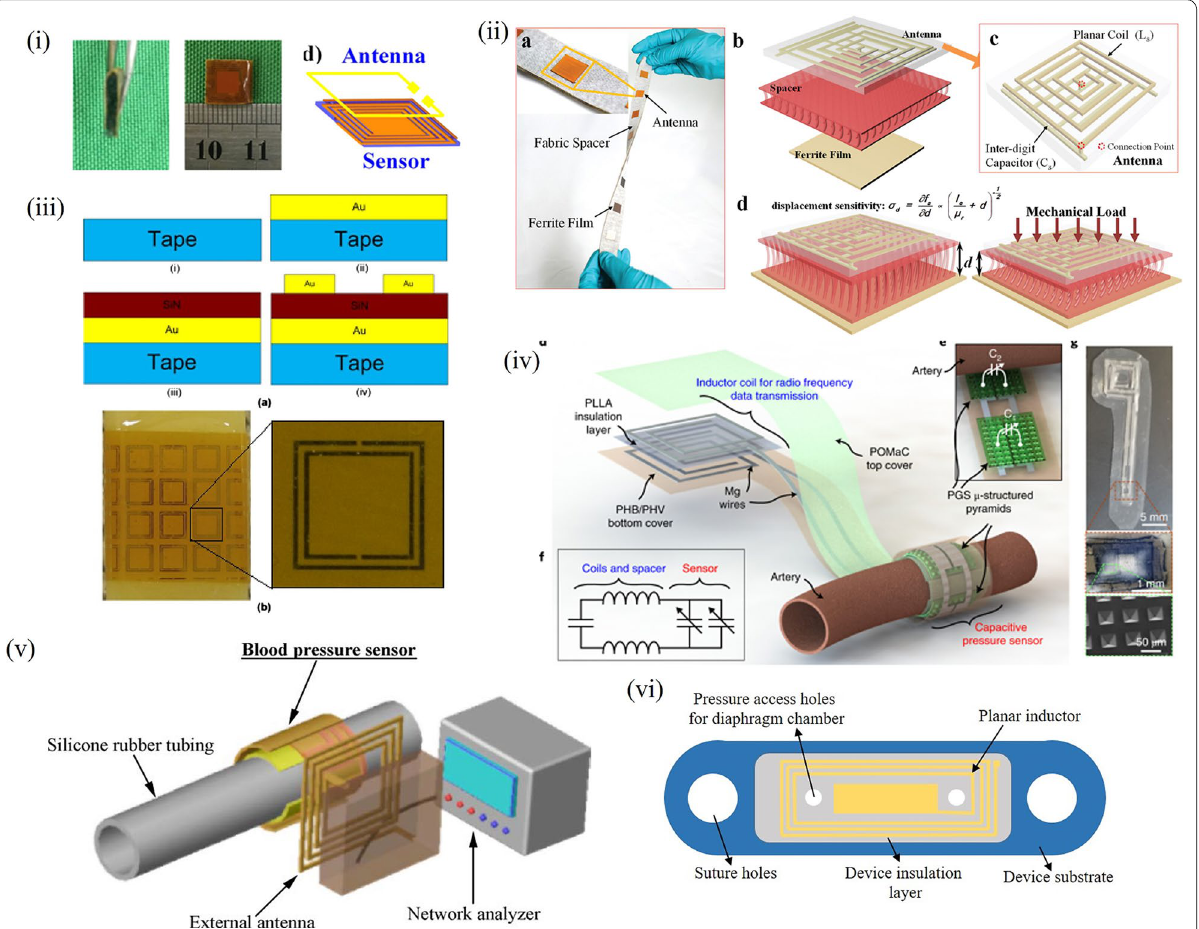
Fig. 9 Wireless pressure sensors (i) GR/PDMS sponge based pressure sensor with attached LC circuit (Reproduced by permission from [190] Copyright 2019,Nature ) (ii) Fabric spacer based capacitive sensor with a ferrite film and LC passive antenna (Reproduced by permission from [180] Copyright 2019, Wiley ) (iii) Tape based sensor fabrication and final integrated antenna based sensor (Reproduced by permission from [176] Copyright 2009, American Institute of Physics ) (iv) Biodegradable micropyramidal patterned sensor with RF data transmission (Reproduced by permission from [181] Copyright 2019,Nature ) (v) Schematic of external in vivo pressure measurement (Reproduced by permission from [191] Copyright 2005,Elsevier ) (vi) Diaphragm based wireless antenna integrated